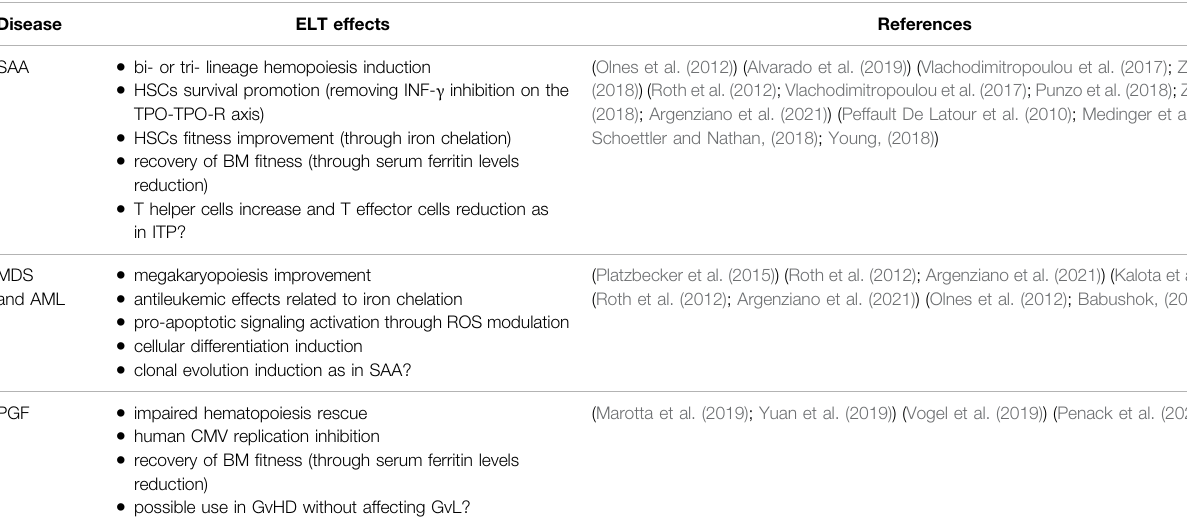
TABLE 1 | ELT effects in diseases other than